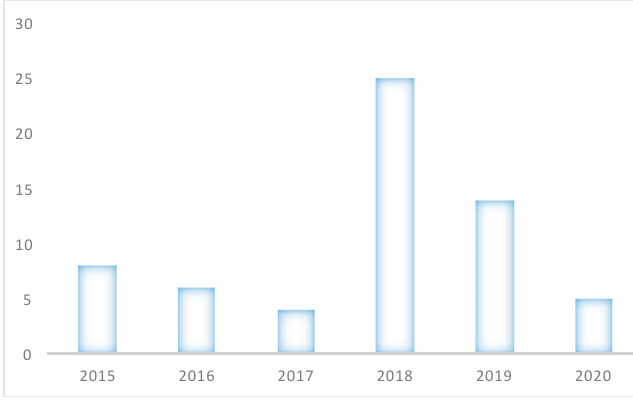
Figure 10. Analysis of the articles according to the year of publication.